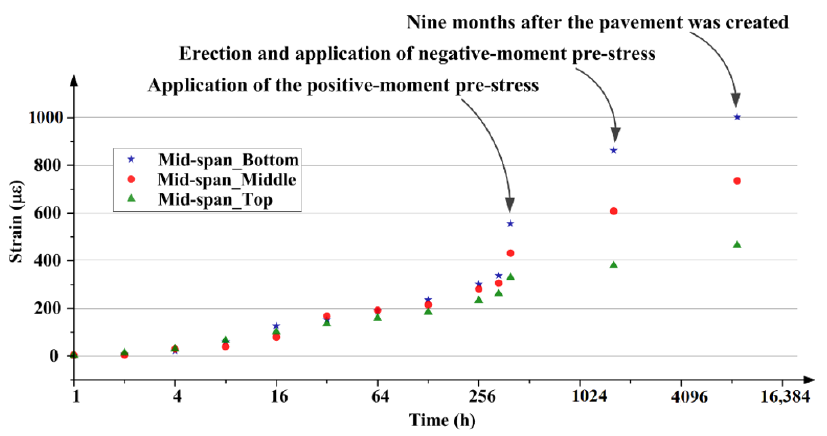
Figure 3. Monitored strain at the mid-span cross-section.